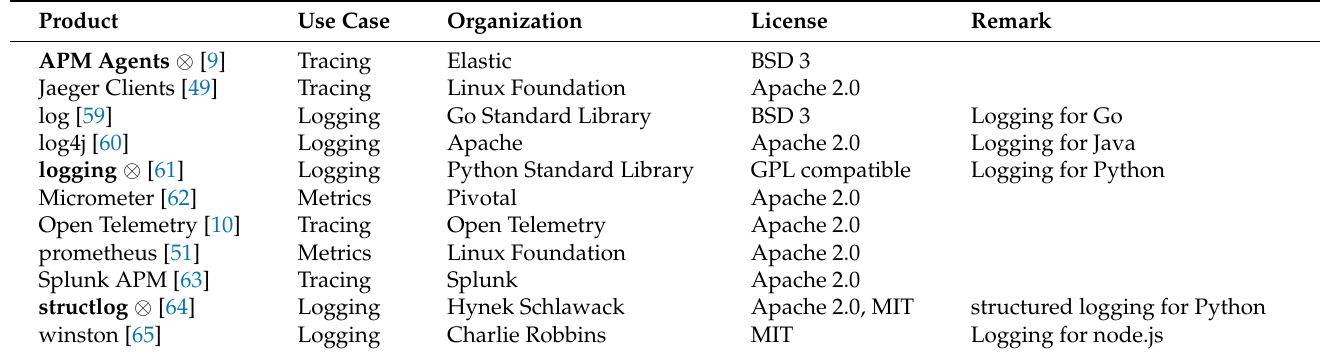
Table 3. Often seen instrumenting libraries. Products that inspired the research prototype are marked bold ⊗ , without claiming